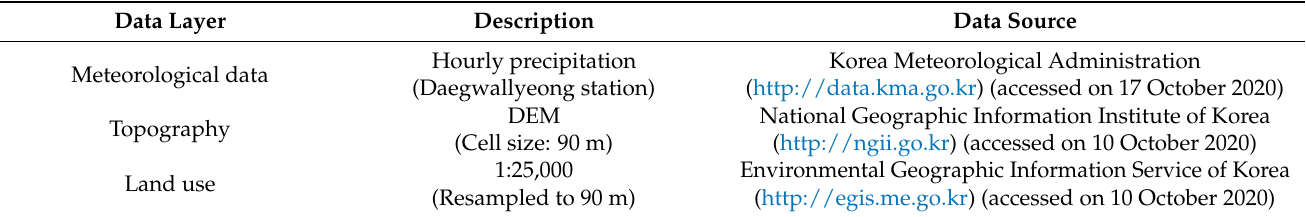
Figure 4. Spatial input data of the R-SSEM; ( a ) elevation, ( b ) flow direction, ( c ) flow accumulation, ( d ) land use. Table 2. Information about the data used in this study.